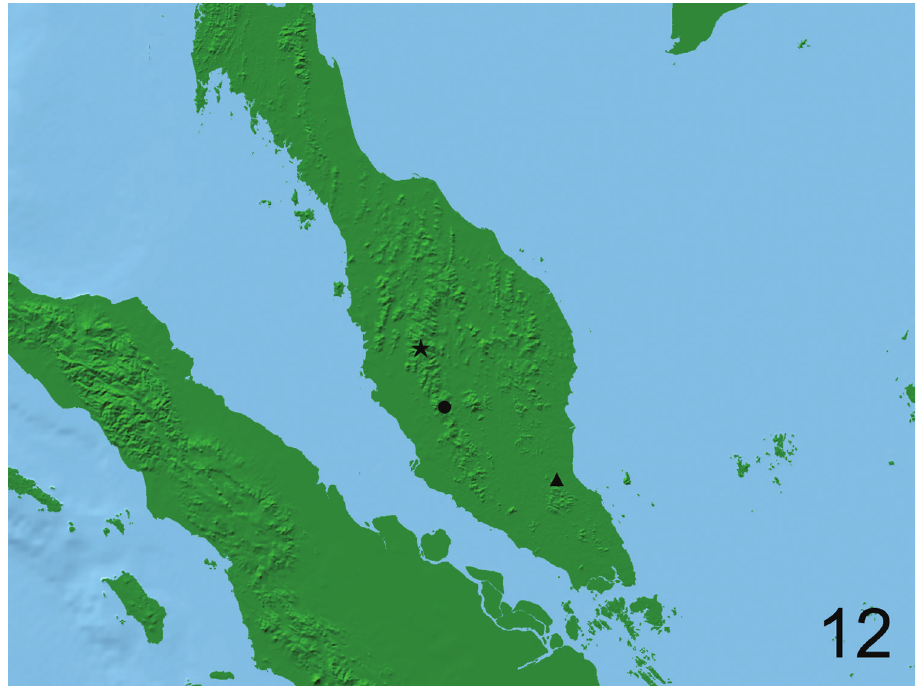
Figure 12. Distribution map of Cheleion species: black star C. watanabei sp. n., black circle C. malaya- num , black triangle C. jendeki